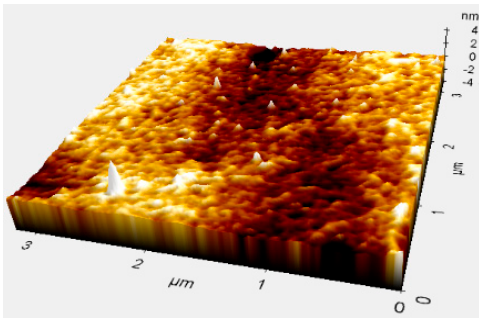
Figure 10. Atomic force microscopy (AFM) graph of surface.